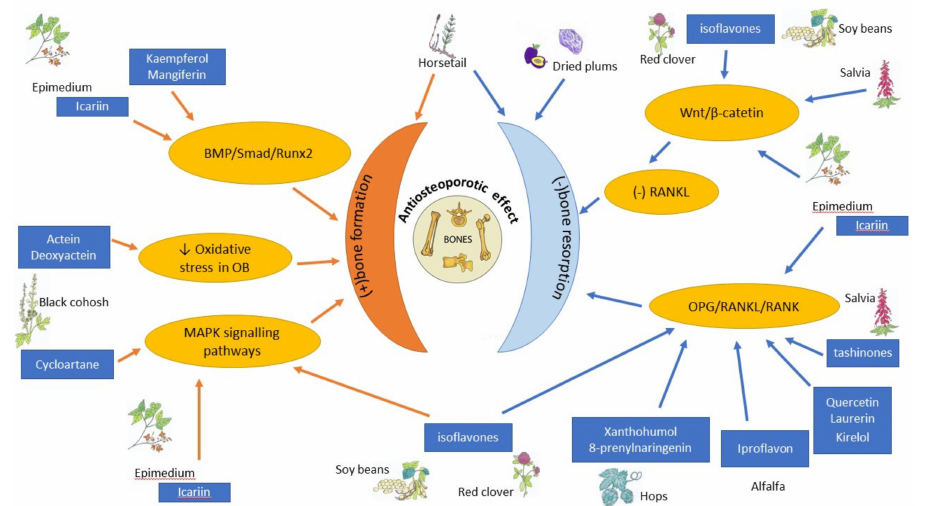
Figure 4. Schematic diagram of the antiosteoporotic activity of various plants and their components. BMP—bone mor- phogenic protein, MAPK—mitogen-activated protein kinase, OB—osteoblast, OPG—osteoprotegerin, RANK—Receptor Activator for Nuclear Factor κ B, RANKL—Receptor Activator for Nuclear Factor κ B Ligand, Runx2—Runt-related tran- scription factor 2, ↓ decreased, (-)—inhibited, (+)